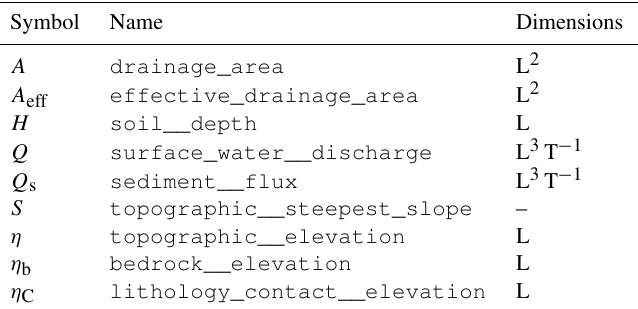
Table 5. Terrainbento field names and unit